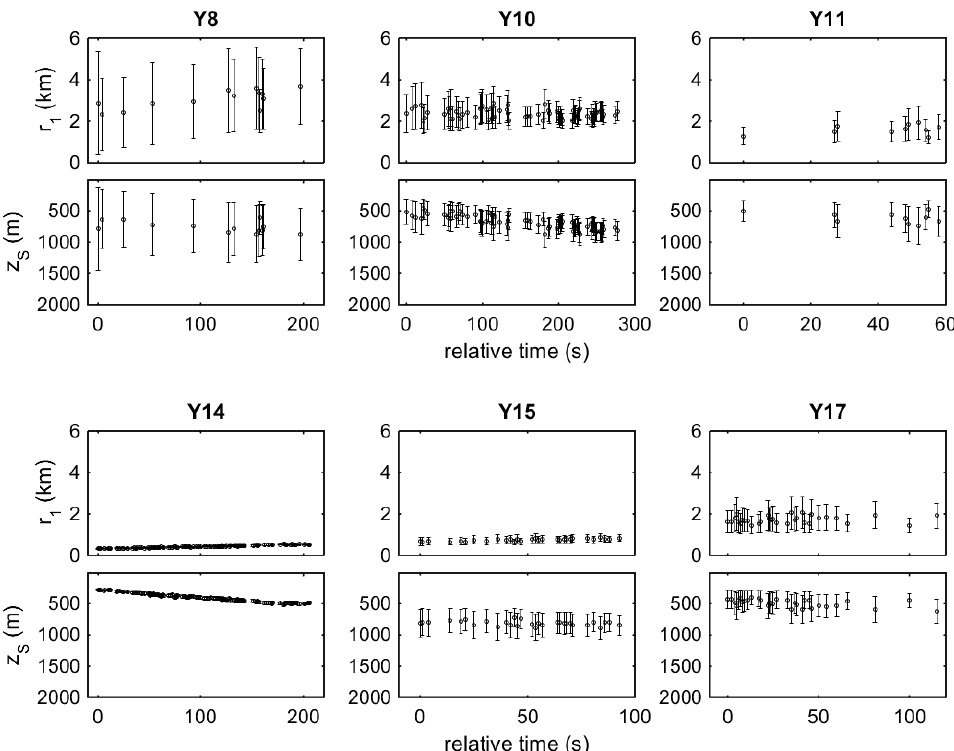
Figure 20. TDOAs of sperm-whale signals and hydrophone depths during stations Y8, Y10, Y11, Y14, Y15, and Y17 of the deep-water experiment on 8 June 2015 aiming at the localization of sperm whale Y for front hydrophone ( ◦ ), rear hydrophone (+) and 21 (×).